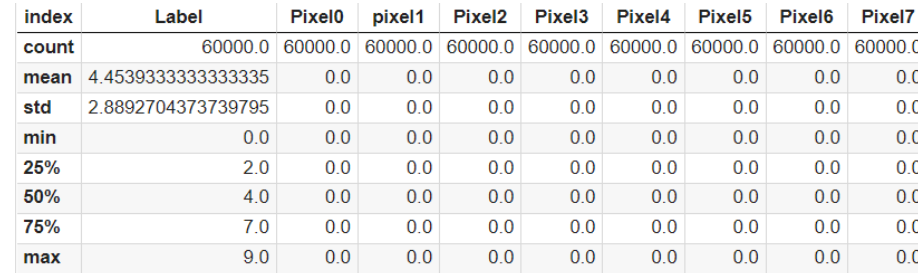
Table 2 – Statistical distribution of the MNIST training